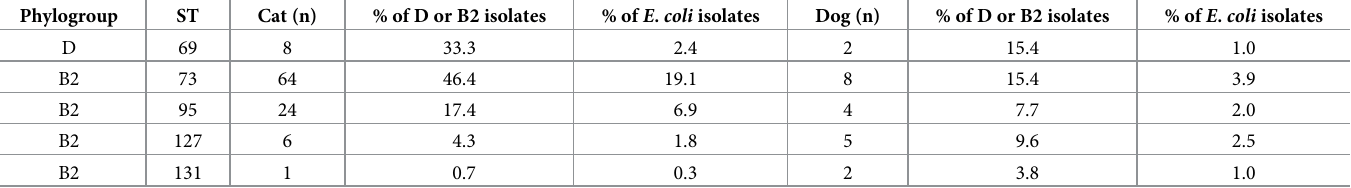
ST, sequence type; n, number of